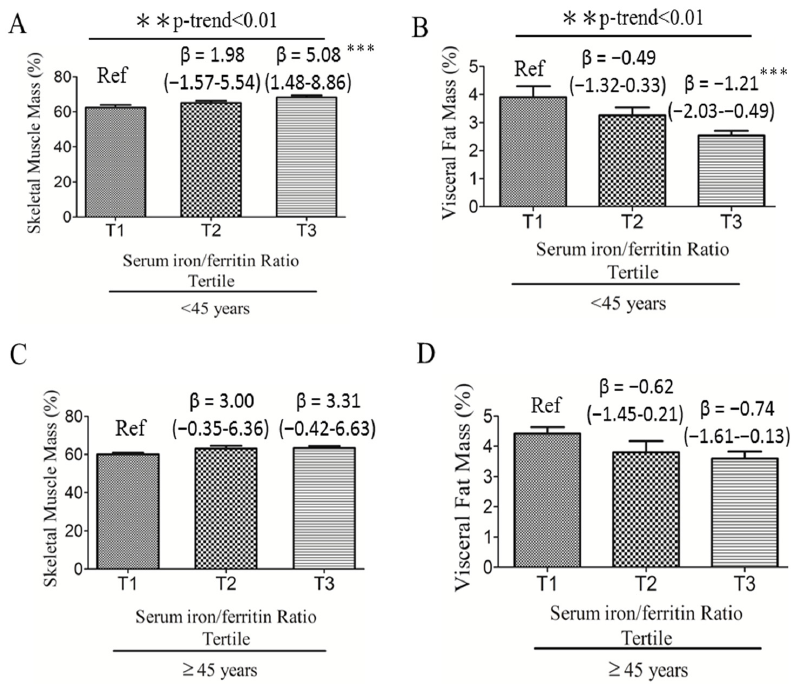
Figure 2. Age-adjusted linear regression analyses of serum iron:ferritin ratio and body compositions according to the tertile group of serum iron:ferritin ratio in young adult ( n = 65) and middle-aged ( n = 52) women. ( A ) Serum iron:ferritin ratio to predict skeletal muscle mass in women <45 years; ( B ) Serum iron:ferritin ratio to predict visceral fat mass in women <45 years; ( C ) Serum iron:ferritin ratio to predict skeletal muscle mass in women ≥ 45 years; ( D ) Serum iron:ferritin ratio to predict visceral fat mass in women ≥ 45 years. ** p < 0.01, and *** p < 0.001 indicate statistical significance. Age ‐ adjusted multivariate logistic regression analysis revealed that the serum iron:ferritin ratio in young adult women was associated with a 47% reduced [OR = 0.53, 95% CI: 0.30–0.95, p < 0.05] risk of progression from mild to moderate and severe fatty liver (Model 1, Table 2). However,